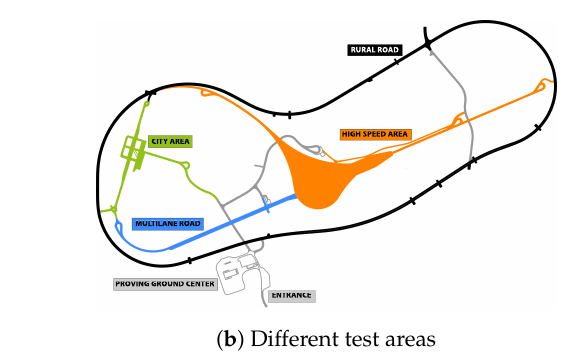
Figure 1. Asta-Zero test